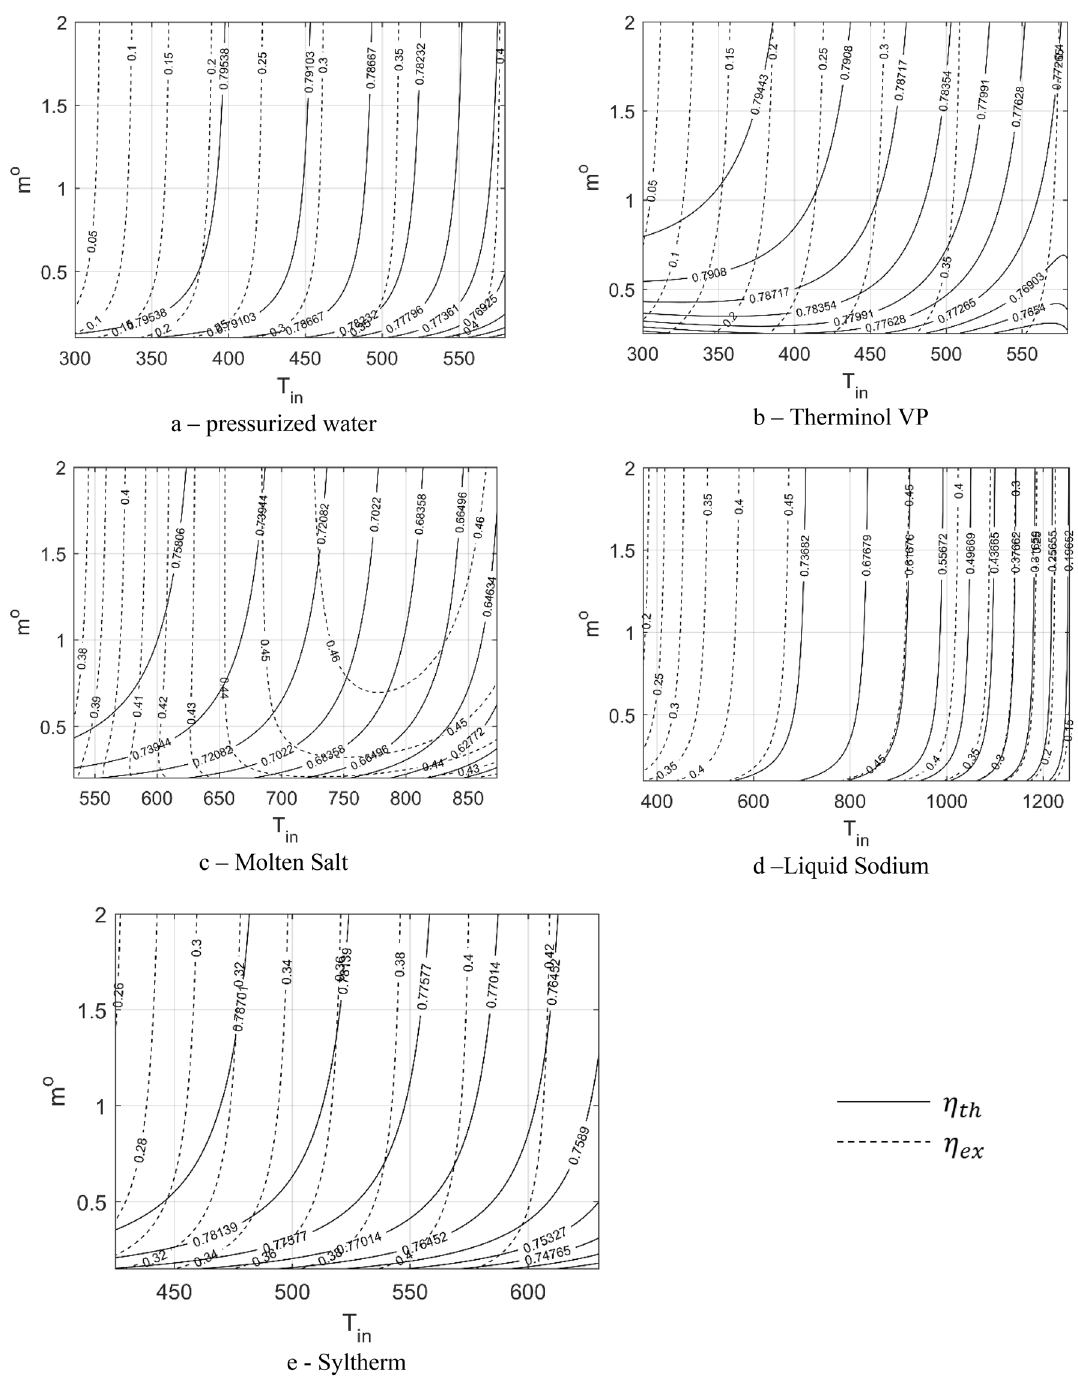
Figure 3. Level curves of the liquid performance in terms of the inlet temperature and mass flow